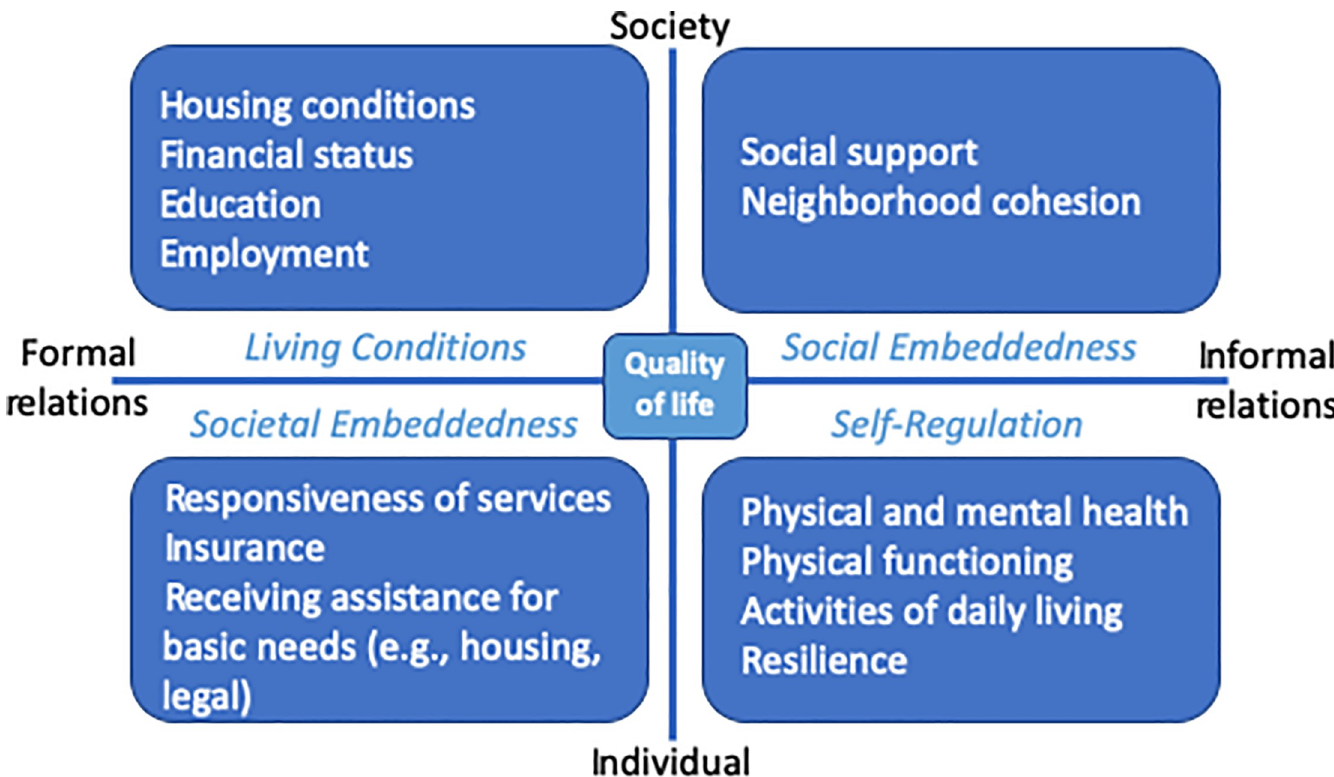
Fig 1. The social quality model. Theoretical framework describing four conditions necessary to support quality of life, adapted from Wolf (2016). [13]